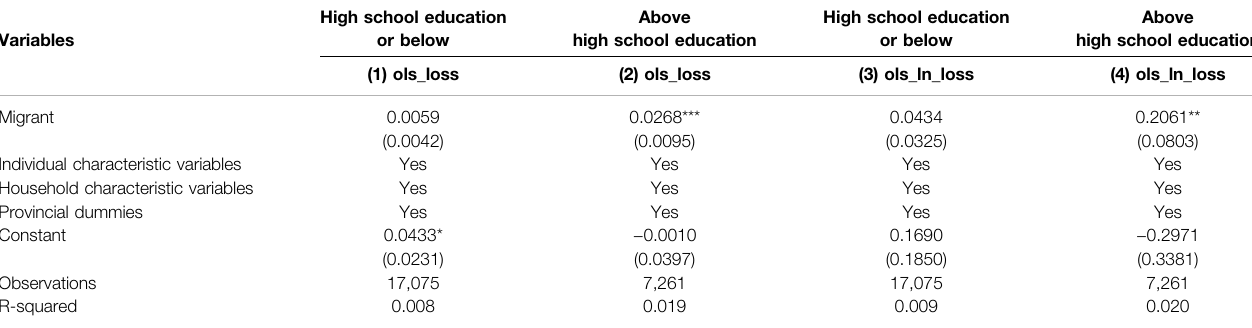
TABLE 3 | The regression of risk of households being defrauded on migrant grouped by